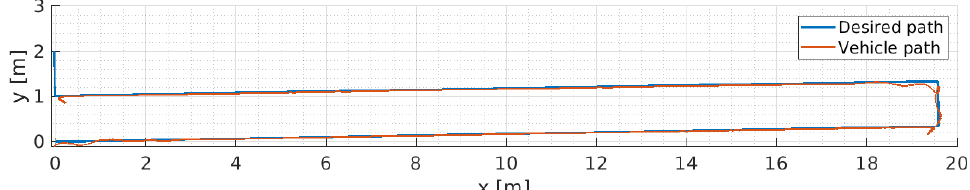
Figure 14. Simulation results for path following employing the modified controller with cross-current of 0.1